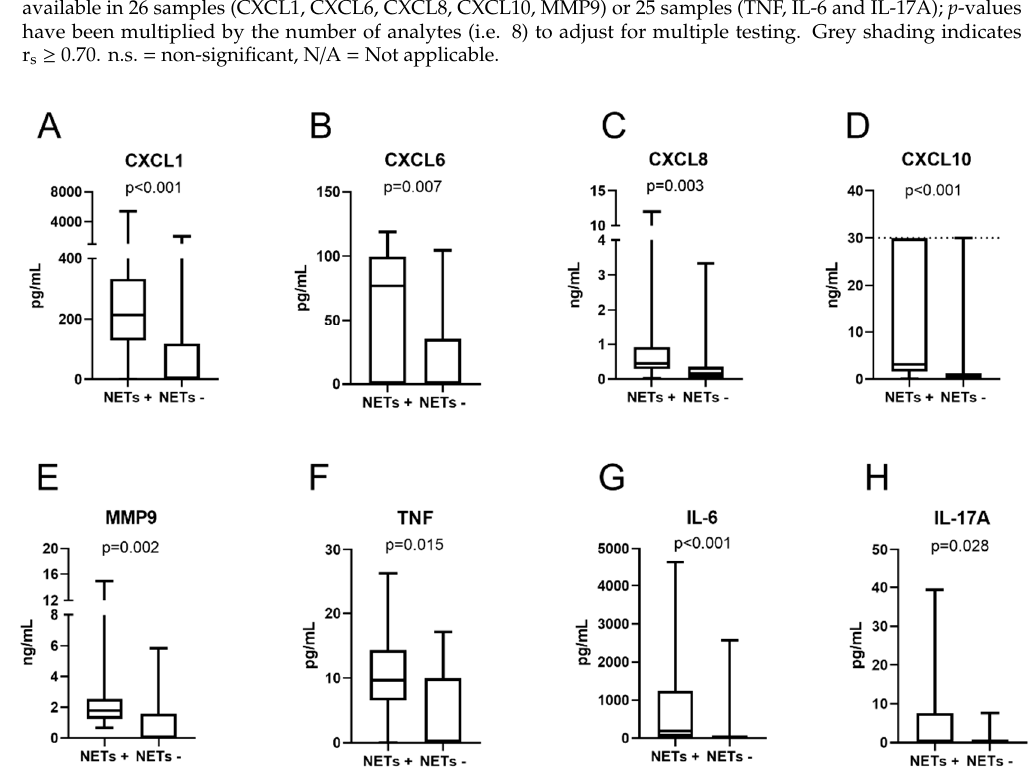
Figure 2. Concentrations of chemokines ( A – D ), MMP9 ( E ) and cytokines ( F – H ) in the CSF samples from the NET remnant-positive and NET remnant-negative children. Whiskers indicate the min-max values. The p -values are derived from the Mann–Whitney U -test. CXCL10 concentrations above the range of quantification ( > 30 ng / mL, N = 5) were assigned a value of 30 ng / mL (upper range of quantification is indicated by a dashed line). NETs: neutrophil extracellular